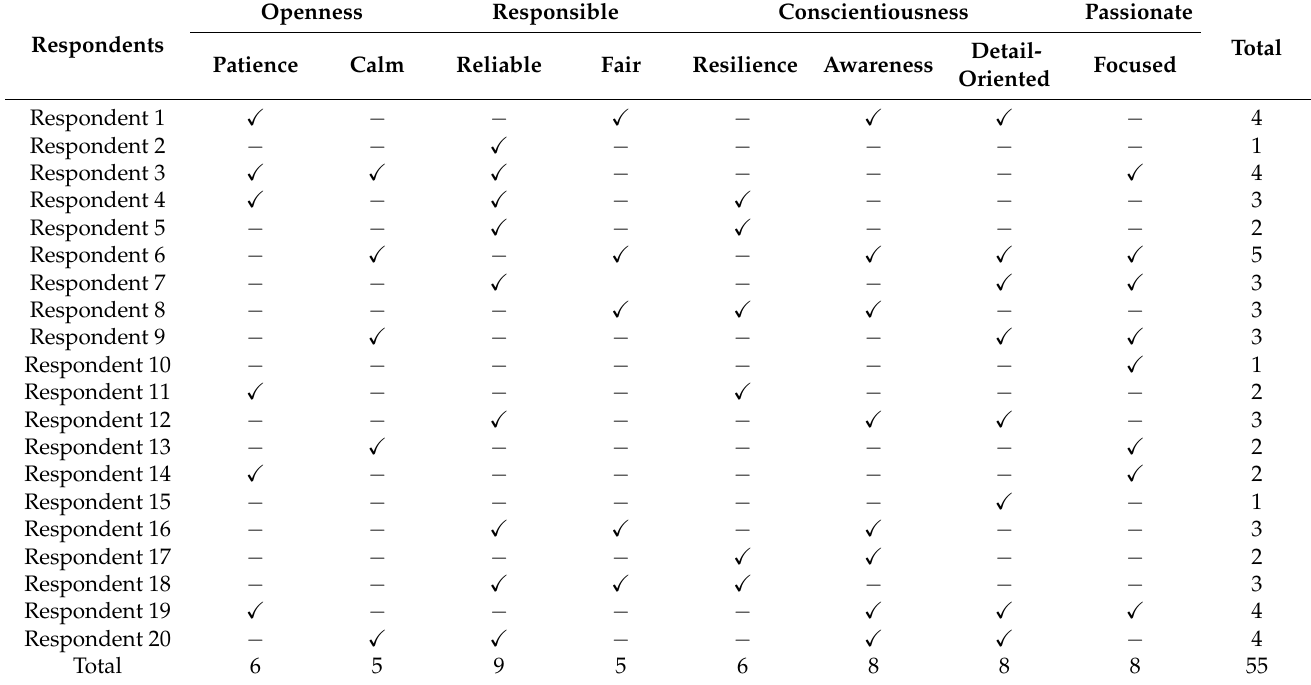
Table 4. Constructive leadership traits in BIM-based construction